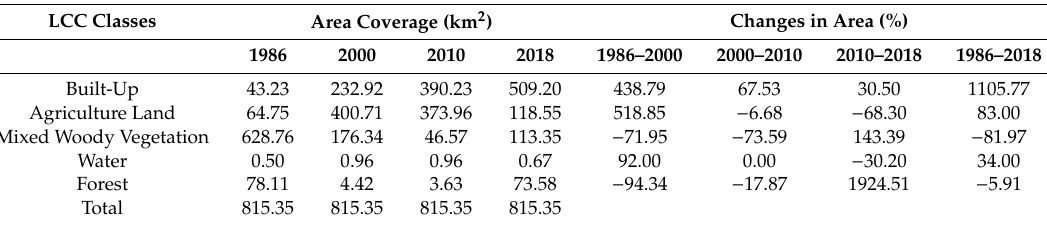
Figure 3. Maps showing land cover change (LCC) characteristics in Kumasi (1986–2018). Note: ‘mixed wood vegetation’ is presented in the legend as ‘mixed vegetation’. Table 1. Land cover characteristics in Kumasi